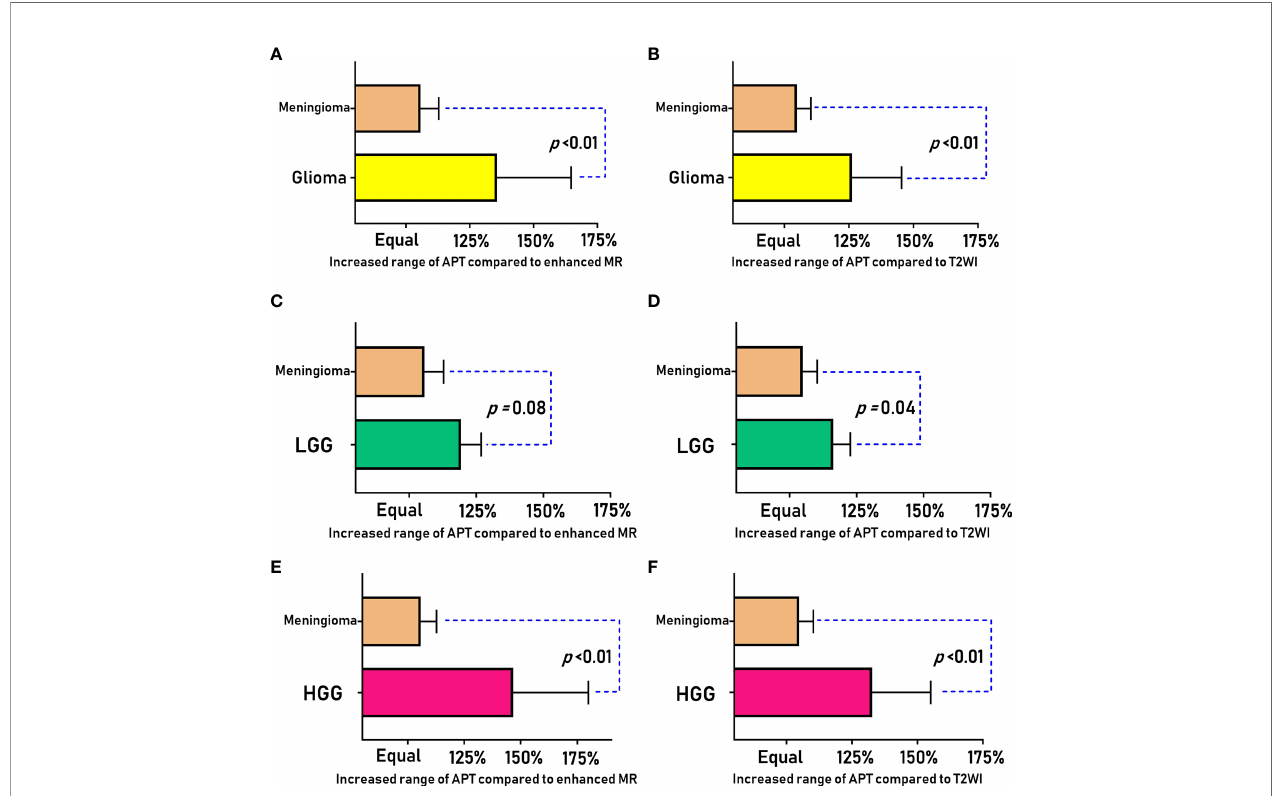
FIGURE 3 | Comparison of the APT enlargement range (R APT/T2 and R APT/E ) between meningiomas and gliomas (LGG and